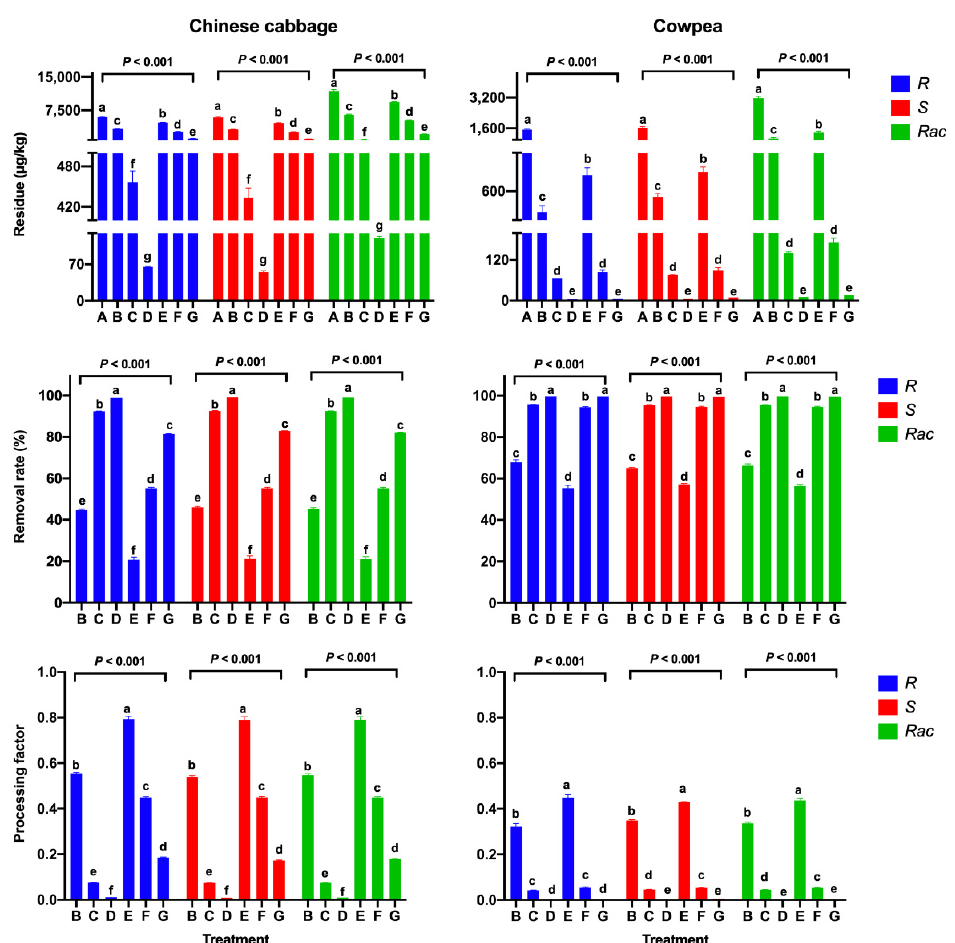
Figure 3. Residues and RRs of mandipropamid enantiomers and racemate and PFs for different